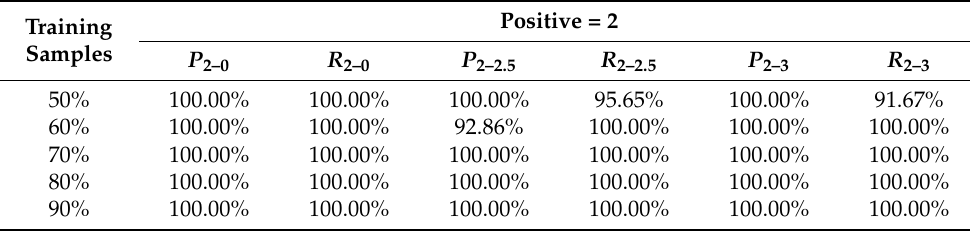
Table 5. Inter-class precision and recall of HY = 2 as